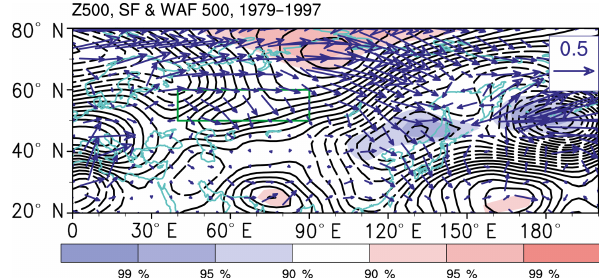
Figure 7. The CC between the SC ES and Z500 (shading, exceeding 90, 95, and 99% confidence levels), stream function (contour), and wave activity flux (arrow) in December from 1979 to 1997. The green box represents the ES area. The linear trend is